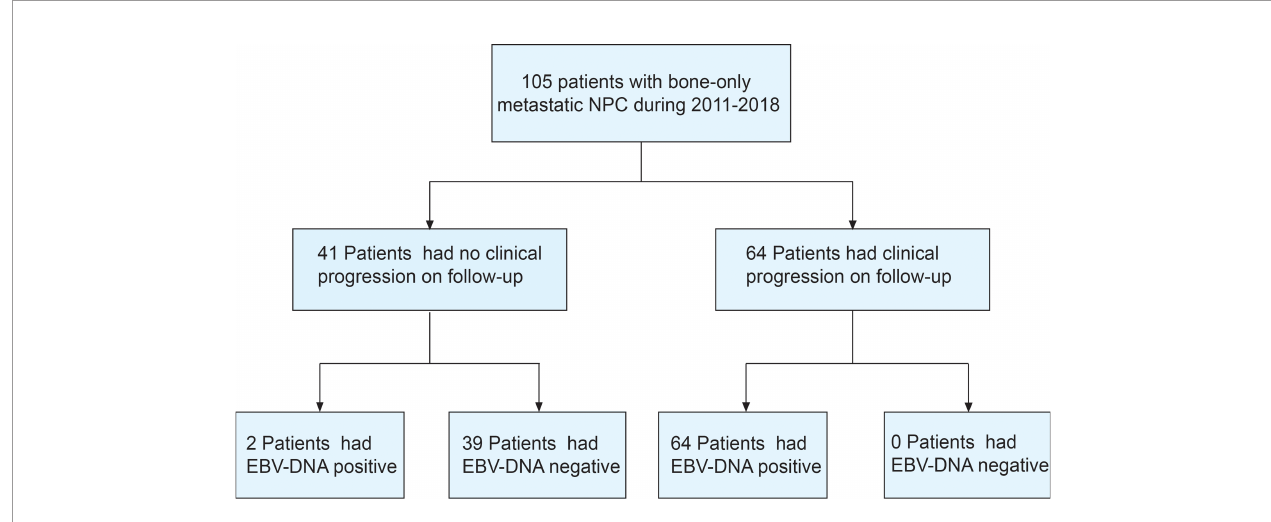
FIGURE 1 | Flowchart of the different groups according to EBV-DNA